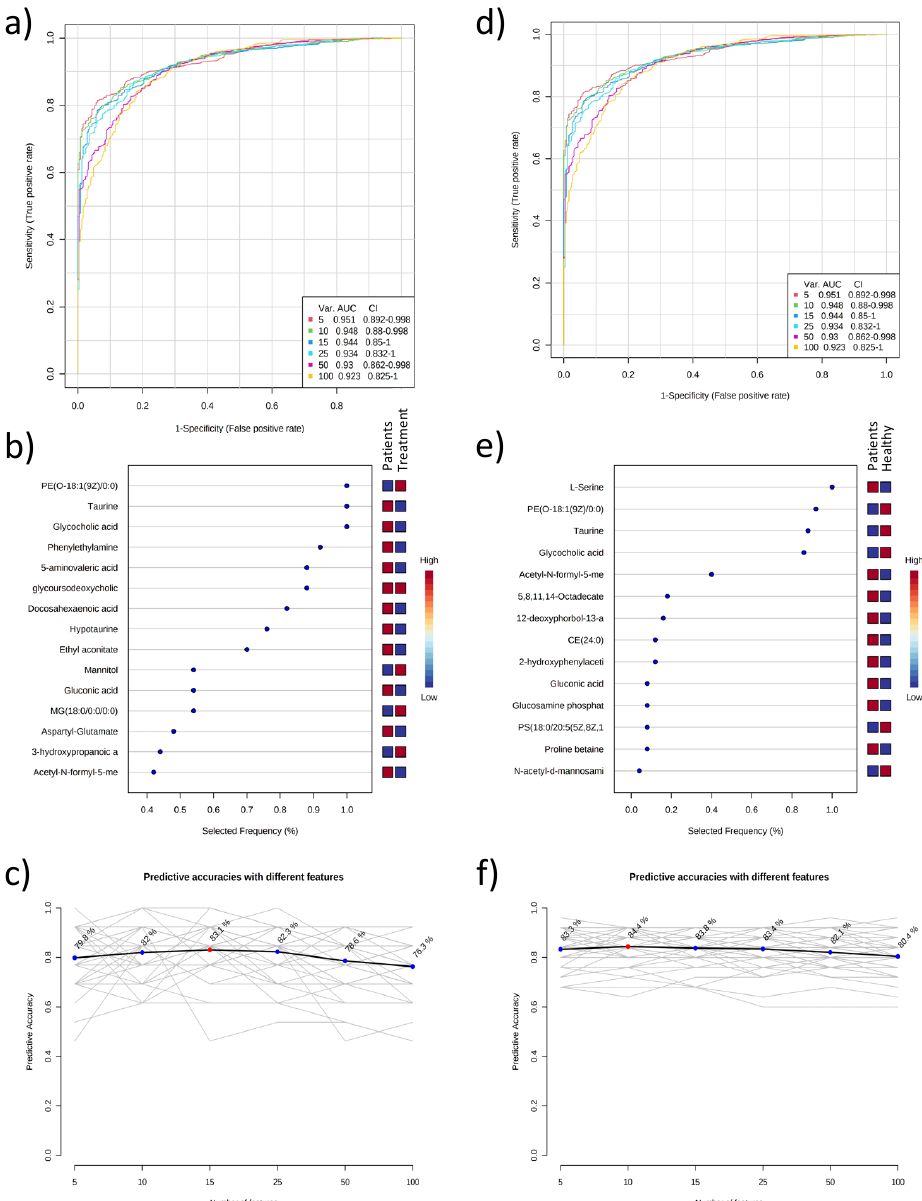
Figure 2. Multivariate ROC curve-based exploration graphs for plasma metabolomics analysis. Patient group and treatment group ( a – c ); patient group and healthy control group ( d – f ) ( a , d ); selectivity and sensitivity graphs ( b , e ); the most significant metabolites on the estimation of the method ( c , f ); effects of different numbers of metabolites on the estimation of the